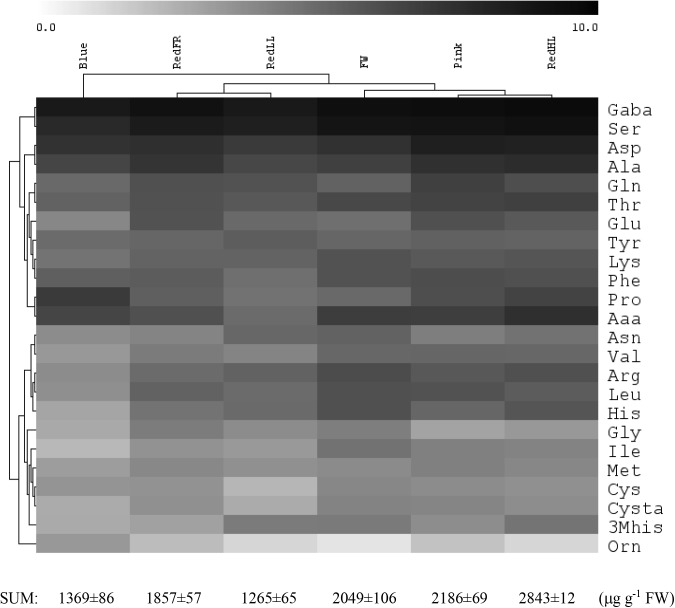
Effect of light spectrum on free amino acid levels in flag leaves. Log2 concentration values are shown. The total amino acid content is shown below. The values are from 5 biological replicates.